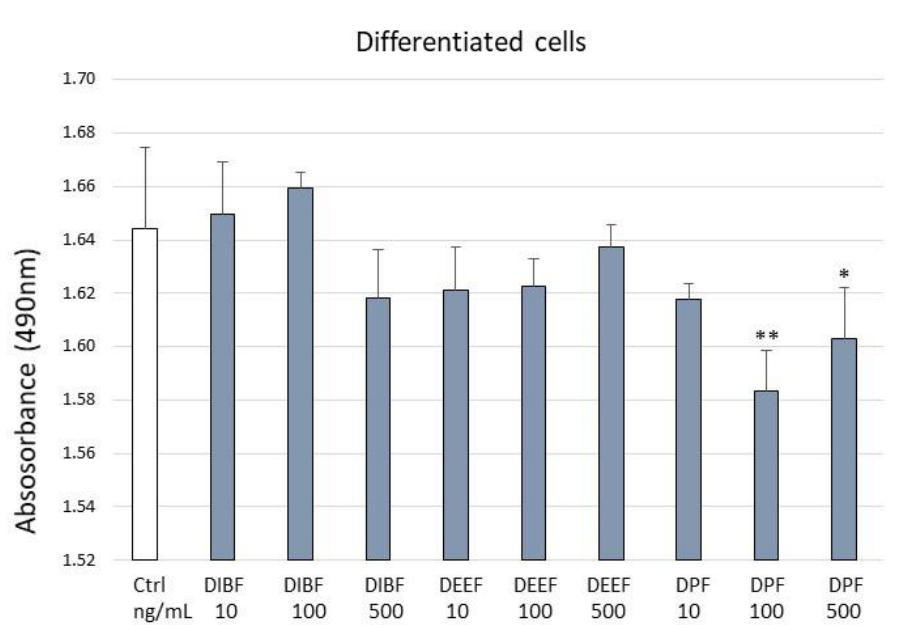
Figure 3. Caco-2 cells treated for 24 h with DIBF, DEEF, and DPF in exponential growth phase, proliferating (at day 3 after seeding). No significant changes in cell viability were observed. The evaluation was performed by MTS assay, as an indirect measure of mitochondrial metabolic capac- ity.